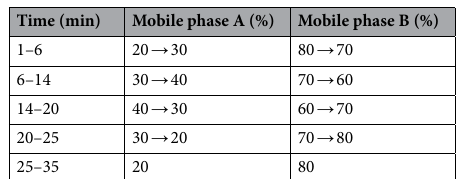
Table 1. Gradient elution of the mobile